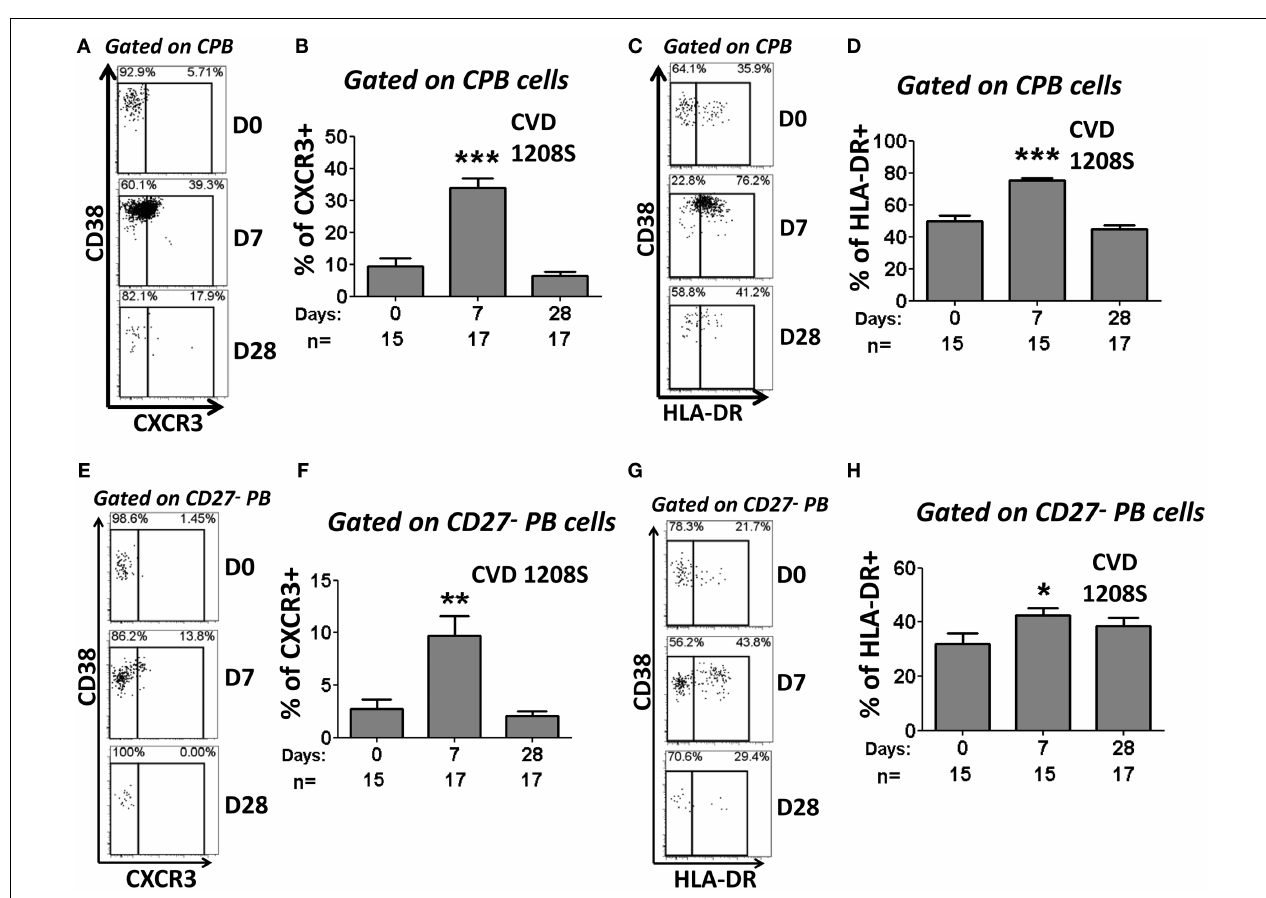
and 28) are shown. Compiled data on the expression of CXCR3 (B,F) and HLA-DR (D,H) in CPB and CD27-PB are shown. Bars indicate arithmetic mean ( ± SEM). Asterisks indicate statistical significance when compared to day 0 (* p < 0.05; ** p < 0.005; *** p <